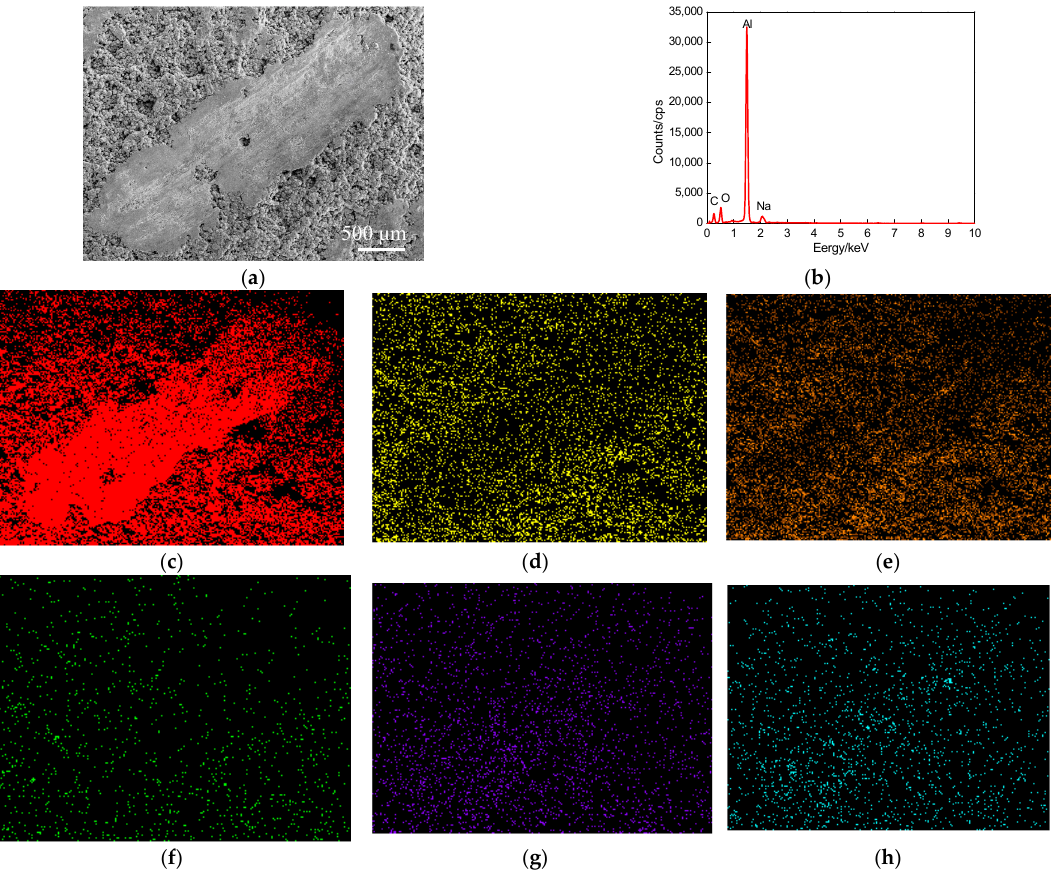
Figure 6. Plane scan analysis of worn track at wear speed of 300 times/min (wear load of 1 N). ( a ) Plane scanned position; ( b ) Result of plane scan analysis; ( c ) Al content; ( d ) C content; ( e ) O content; ( f ) Fe content; ( g ) Na content; ( h ) Cl content.